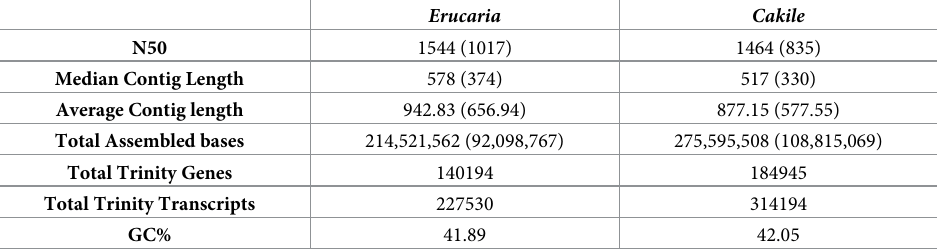
Table 1. Statistics for de novo Trinity assembly of Erucaria erucarioides and Cakile lanceolata pairwise reads for all isoforms. Numbers in parentheses refer to longest isoform